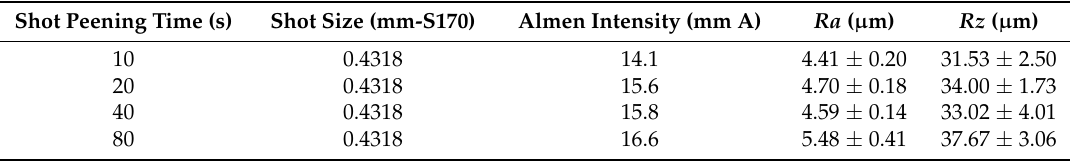
Table 2. Shot peening